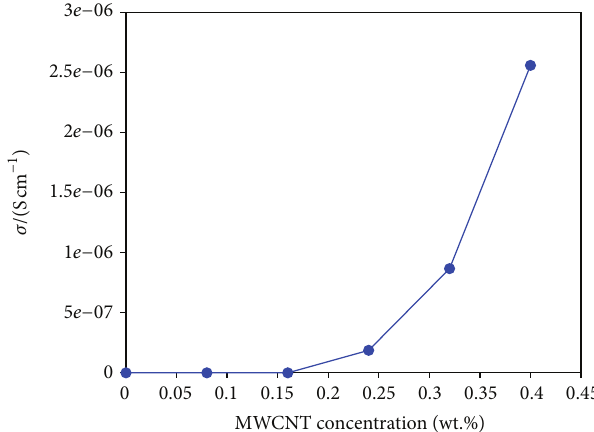
Figure 4: Electrical conductivity of coating films prepared; the line is a guideline for the eye.